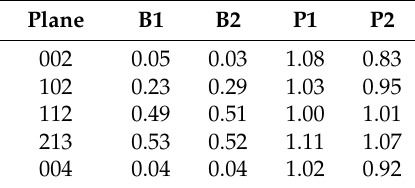
Figure 3. XRMD patterns of HAPs (B1, B2, B3) and XRD patterns of powder HAPs (P1, P2) in bones of Cololabis saira ; [17]: standard XRD pattern of ICDD 01-086-0740, B1: fishbone, B2: 161212, B3: measured on the elongation surface of fishbone, P1: normal powder, P2: fried-powder. For additional meanings of B1, B2, P1 and P2, see Table 1. Table 5. Values of textural index R.